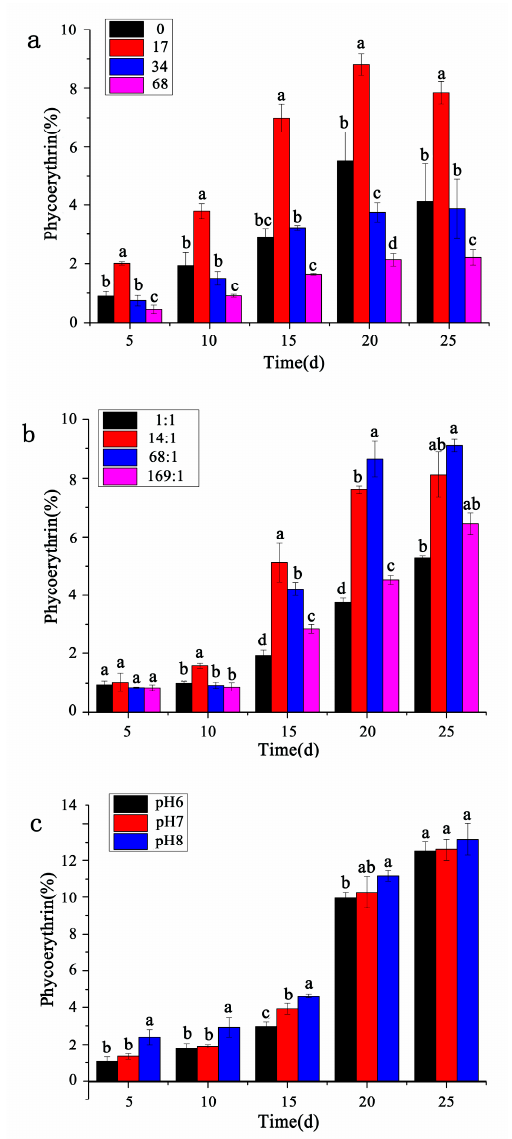
Figure 5. The content of phycoerythrin of P. purpureum under di ff erent environmental factors. Data were expressed as mean ± standard error. ( a ). The content of phycoerythrin of P. purpureum at di ff erent salinities. ( b ). The content of phycoerythrin of P. purpureum at di ff erent nitrogen-to-phosphorus ratios. ( c ). The content of phycoerythrin of P. purpureum at di ff erent pH